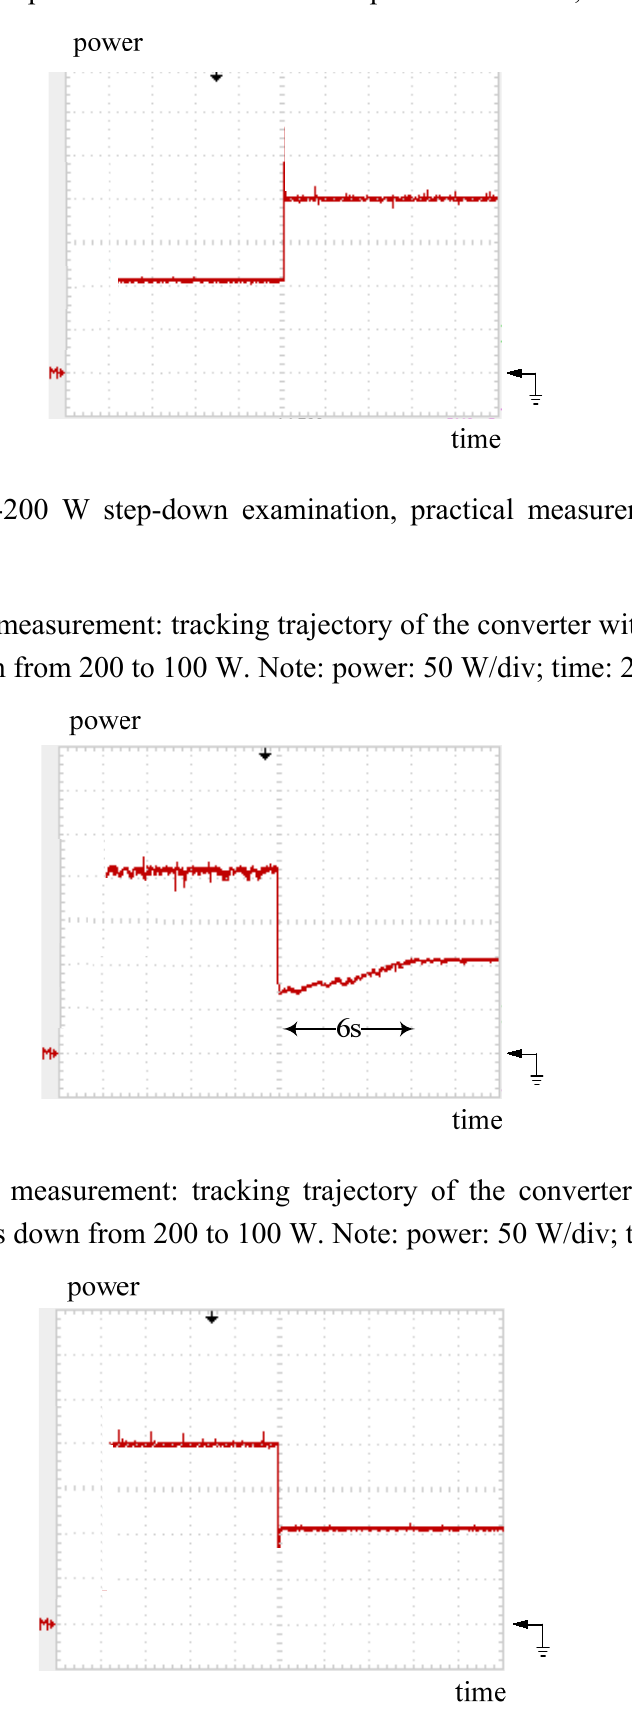
Figure 23. Practical measurement: tracking trajectory of the converter with the DLAA while PV power steps up from 100 to 200 W. Note: power: 50 W/div; time: 0.5 s/div.